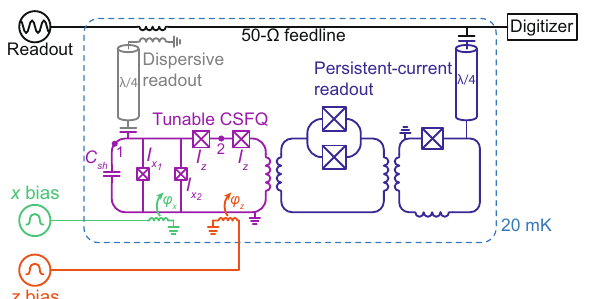
Fig. 1 Simpli fi ed schematic of the experimental setup. The four- junction CSFQ (purple) is controlled via two bias lines that thread x (green) and z (orange) fl uxes into their corresponding loops. The fl ux waveforms have a 1-ns time resolution. The qubit is coupled to a dispersive readout resonator (gray) and to a persistent-current readout circuit (dark blue). The latter measures the direction of the circulating current in the qubit z loop. Note that the CSFQ fl oats in the physical device; the displayed ground de fi nes the zero point for the circuit node parameters in the Hamiltonian derivation. Details of the persistent-current readout can be found in ref. 37 . Relevant device parameters are discussed in “ Methods ”